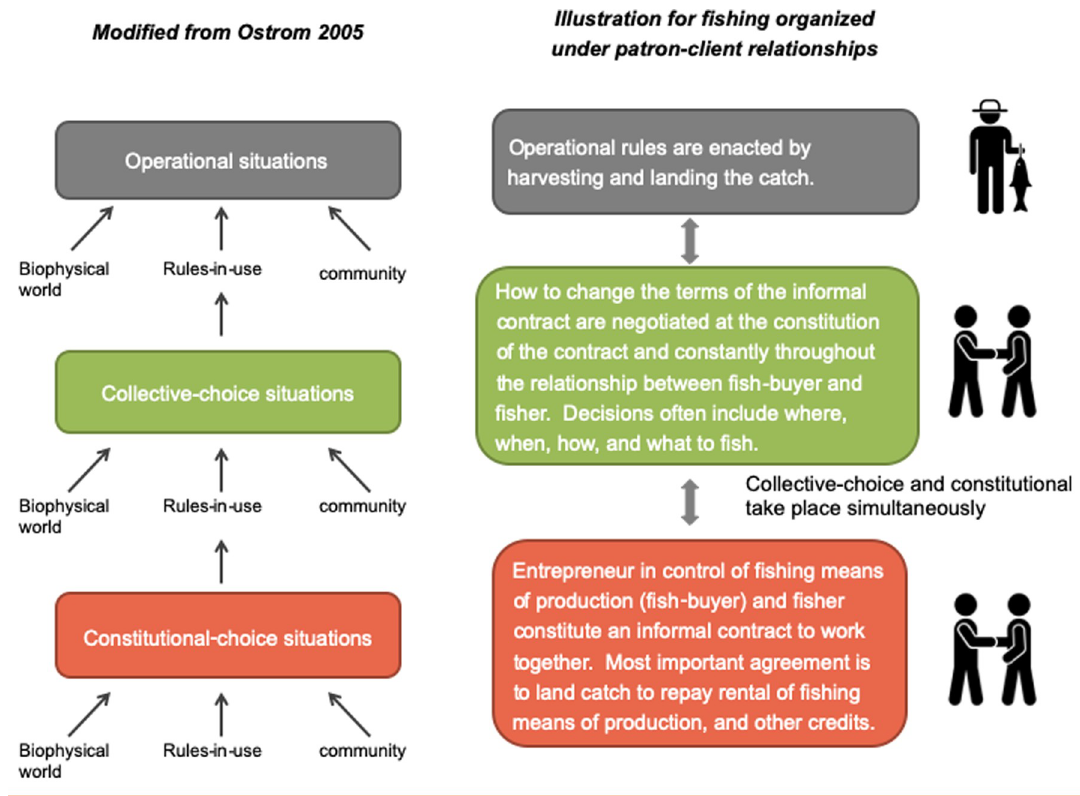
Fig 1. Levels of analysis adapted to the context of small-scale fishing using patron-client relationships as an example.